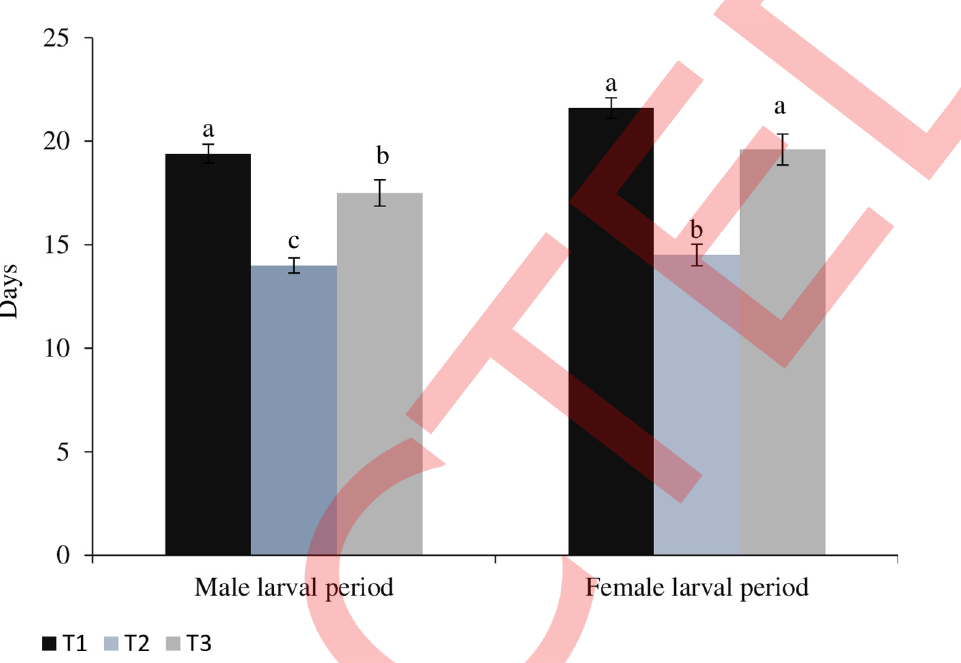
Fig 7. Larval period (mean ± SE) of male and female P . gossypiella on wheat germ, okra and chickpea diet. The means followed by bar gram by same letters are not significantly different at p > 0.05 by Tukey’s HSD